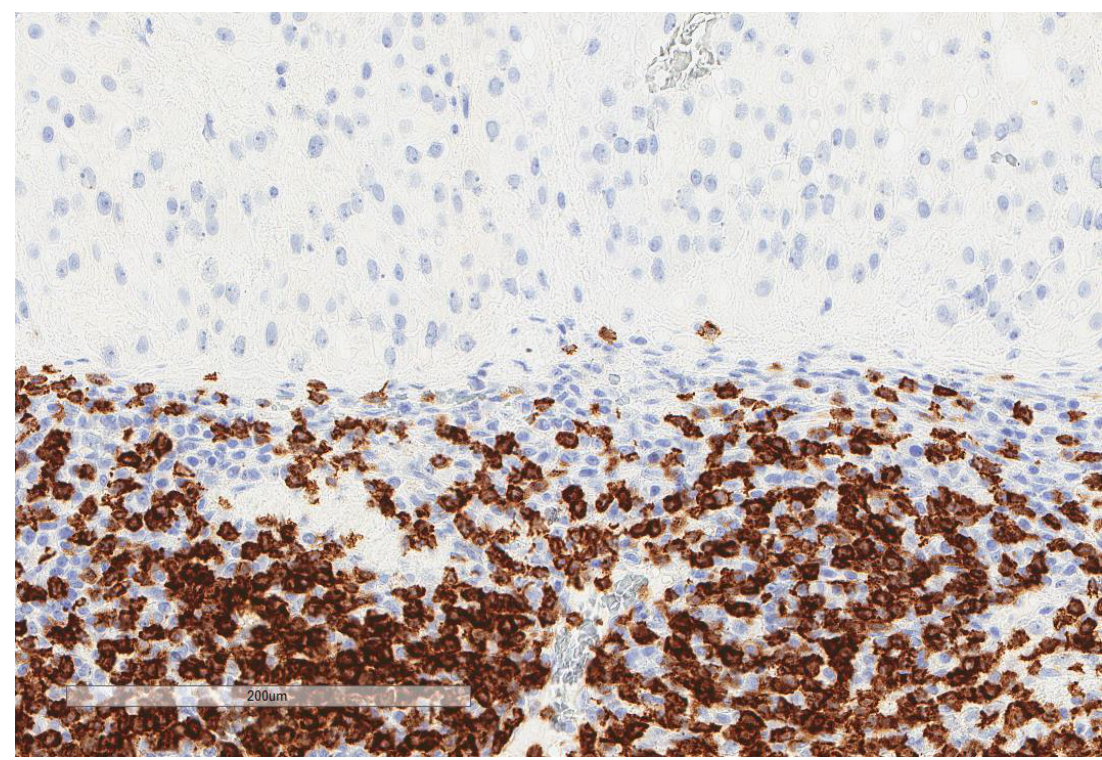
Figure 3. Representative microscopic image (×200 magnification) of high CD4 expression. The right part of the image shows the tumor, and the left part shows the inflammatory cells.